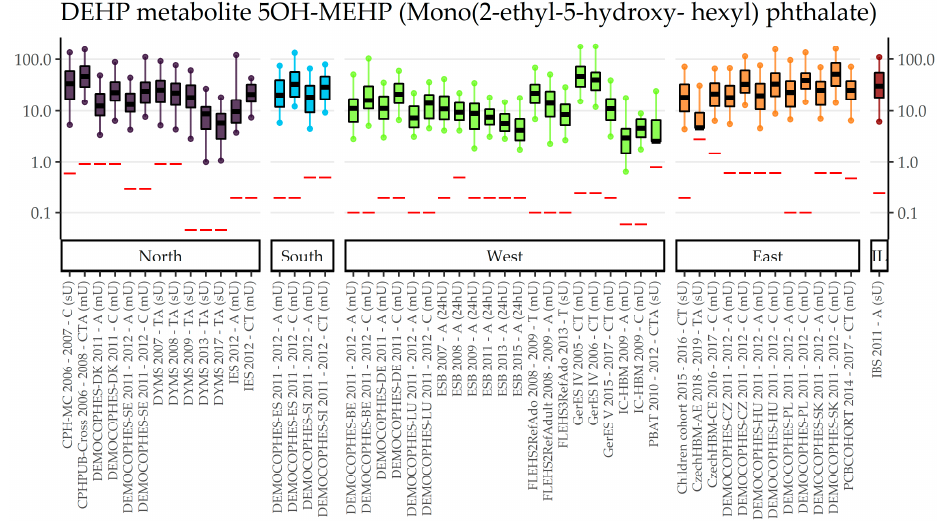
Figure 2. DEHP metabolite 5OH-MEHP concentration in µ g/L in boxplots. The box is based on P25, P50, and P75, and the whiskers are based on P5 and P95. Boxplots are presented separately by regions (North = violet, South = blue, West = green, East = orange, Israel = dark red) within regions chronologically sorted by year of sampling. Red lines denote LOQ/LOD for the respective study. Since percentiles are only available and displayed when they are above LOQ/LOD, the lower side of boxplots might be truncated. The age categories are shown in capital letters: children of the age groups 3–5 and 6–11 (C), adolescents between 12 and 19 years (T) and adults from the age groups 20–39, 40–59 and 60 years and older (A). The sampling method is indicated in brackets: first morning urine void (mU), spot urine (sU) and 24-hours urine